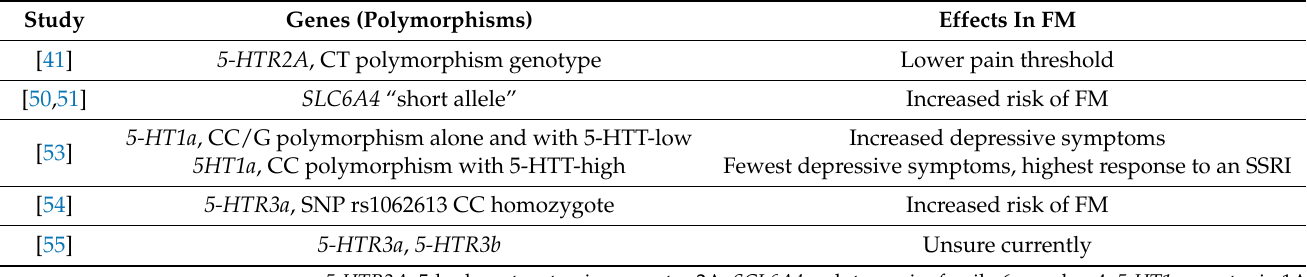
Table 2. Associations of Genes in the Serotonin Pathway and FM Development and